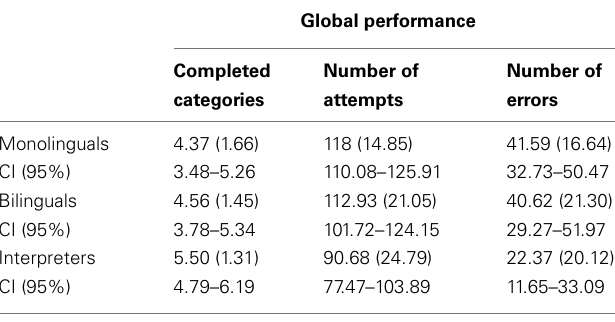
Table 2 | Mean number of completed categories, attempts, and errors (and SD) for each group of participants. CI: 95% confidence